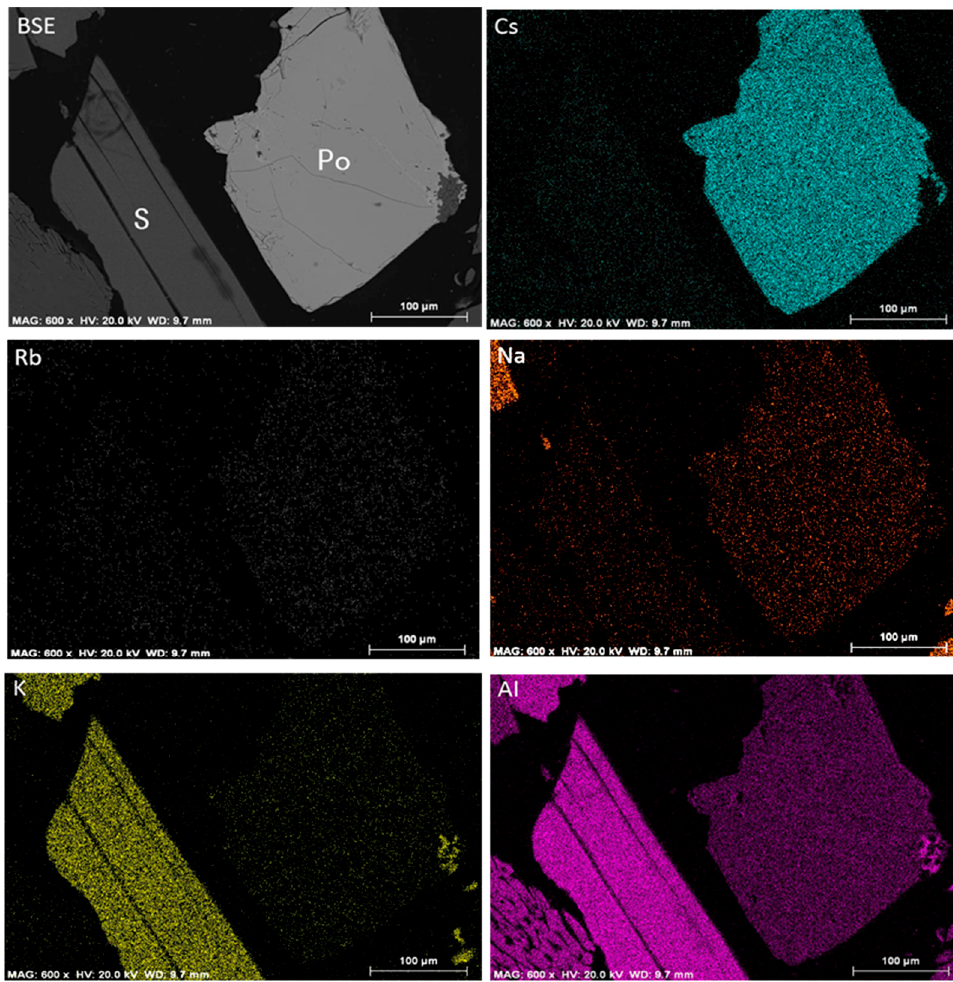
Figure 7. SEM–EDS spectrum of pollucite (Po) and mica (S).